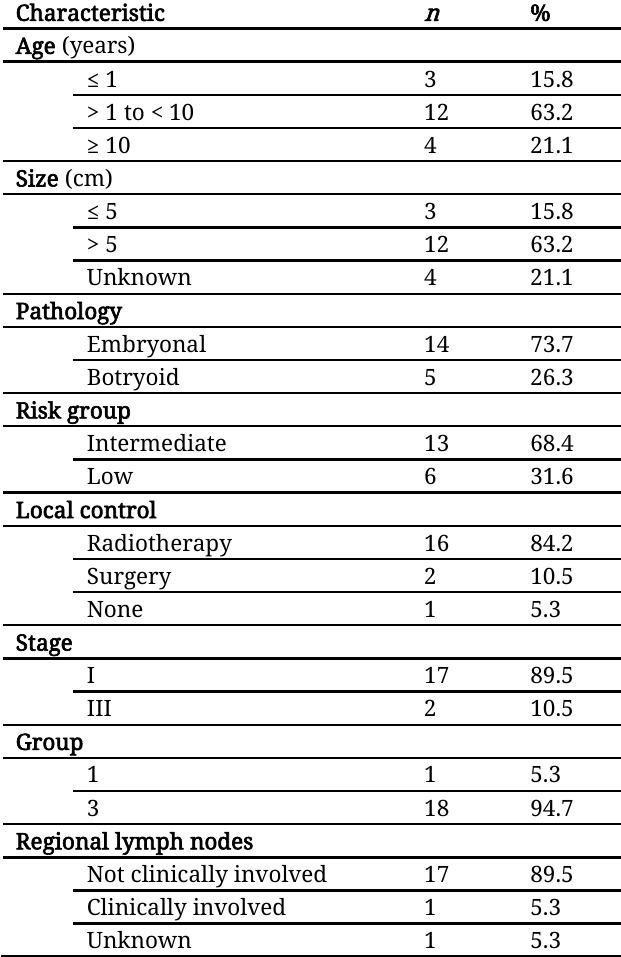
Table 1: Characteristics of 19 children with vaginal rhabdomyosarcoma